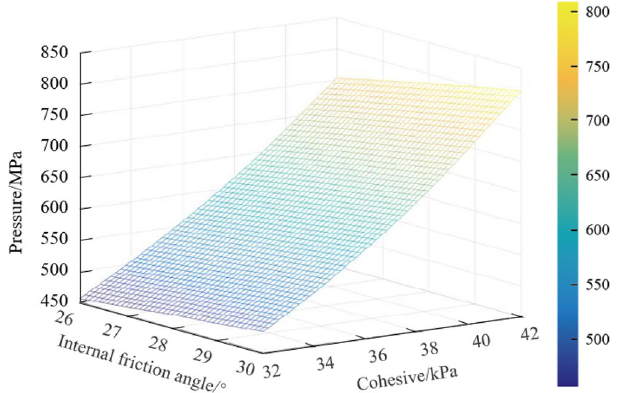
Figure 2. The influence of internal friction angle and cohesion of elastic–plastic soils on fracture pressure.